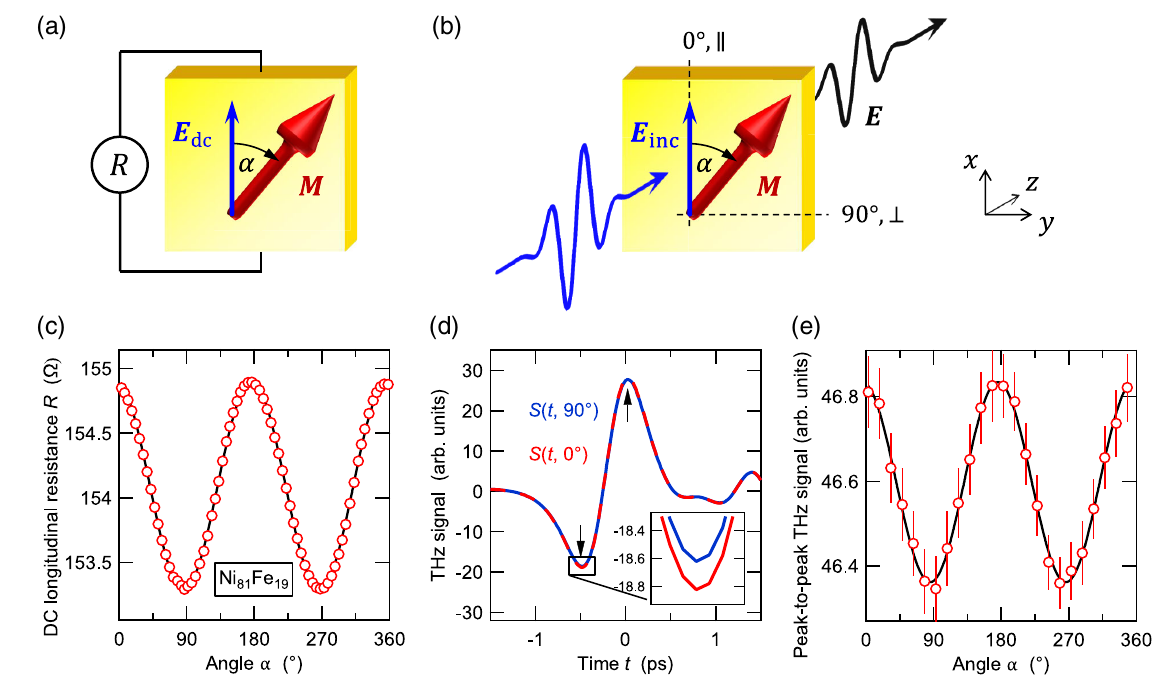
FIG. 1. Measuring dc and THz AMR. (a) Schematic of a dc electrical AMR measurement. The resistance R of a magnetic thin film with magnetization M (red arrow) is measured along the applied dc electric field E (blue arrow) for different rotation angles α of M . dc ð t Þ (blue arrow) is incident on (b) Schematic of the THz AMR measurement. An x -polarized THz pulse with transient electric field E inc the magnetic thin film. After traversal of the sample, we detect the x component of the THz electric field E , that is, E projected onto the fixed direction of E , as a function of the magnetization angle α . (c) dc longitudinal resistance of Ni 81 Fe 19 vs α (red open circles) with a inc fit by R ⊥ þ Δ R cos 2 α (black solid line). (d) THz waveforms S ð t; α Þ for α ¼ 90 ° (blue solid line) and 0° (red dashed line) vs time t for the emitter-detector configuration covering the frequency range 0.2 – 2 THz. The inset shows a magnified version of the signal around its minimum, indicating a signal change of about 1%. (e) Peak-to-peak amplitude of the THz signal waveform S ð t; α Þ as a function of α (open circles) with a fit as in panel (c). The signal extrema used for the evaluation are indicated by the black arrows in panel